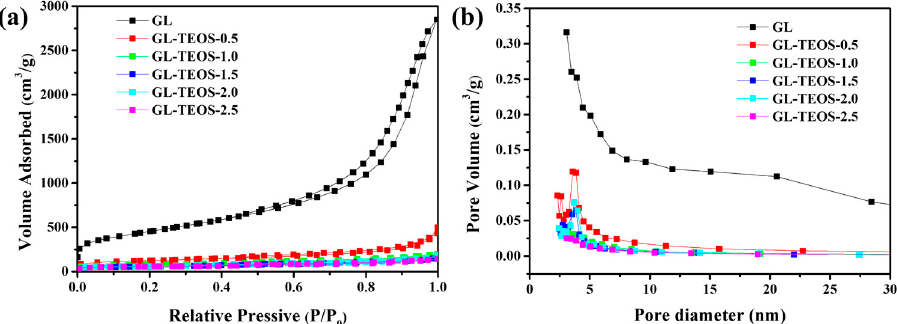
Figure 9. ( a ) Nitrogen adsorption/desorption isotherms and ( b ) corresponding pore size distribution of GL and GL-TEOS-x (x = 0.4, 0.8, 1.2, 1.6, and 2.0). Table 2. The speci fi c surface areas investigated by Brunauer–Emme tt –Teller (BET) (S BET ) and pore vol- ume of GL and GL-TEOS-x (x = 0.5, 1, 1.5, 2, and 2.5).